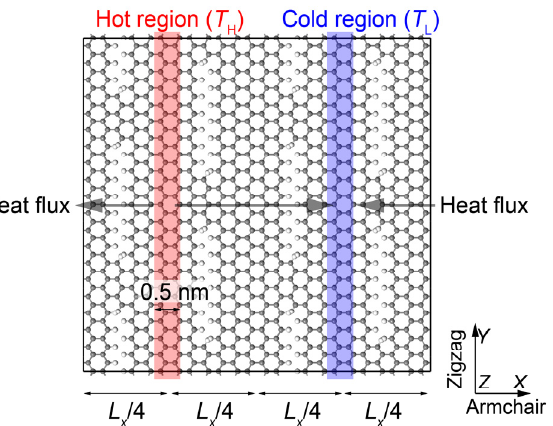
Figure 2. The setup for nonequilibrium molecular dynamics (NEMD) simulations to measure the thermal conductivity of GK. thermal conductivity of